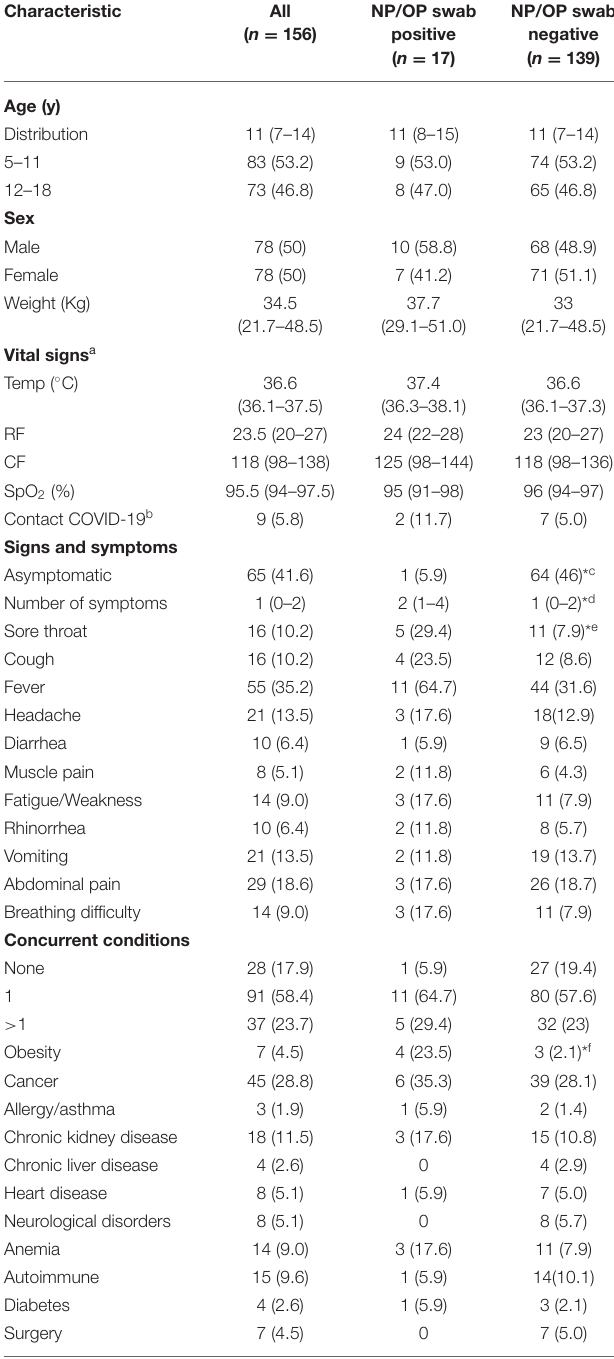
TABLE 1 | Clinical characteristics of the pediatric patients whose results were used to calculate sensitivity and specificity of the test in saliva.